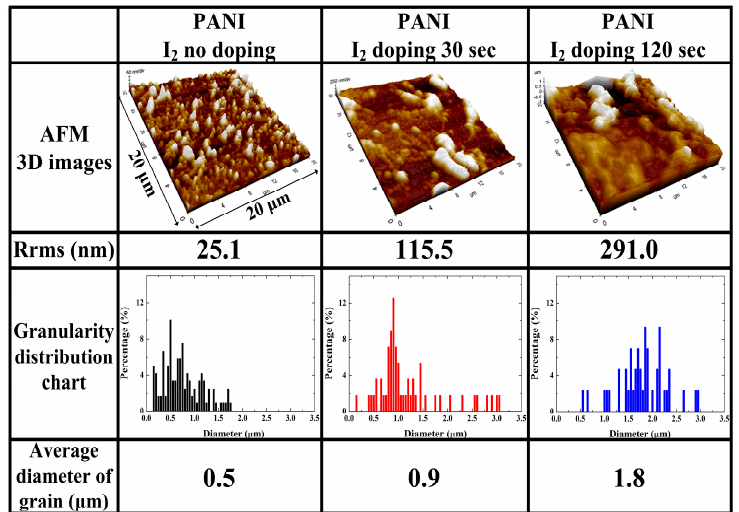
Figure 3. Three-dimensional (3D) atomic force microscope (AFM) images of roughness (R rms ) of PANI film surfaces grown on glass substrates and granularity cumulation distribution charts with average grain diameter obtained from AFM images when using advanced APPJs device after 30 min deposition without I 2 doping, with 30 s I 2 doping, and with 120 s I 2 doping following deposition.